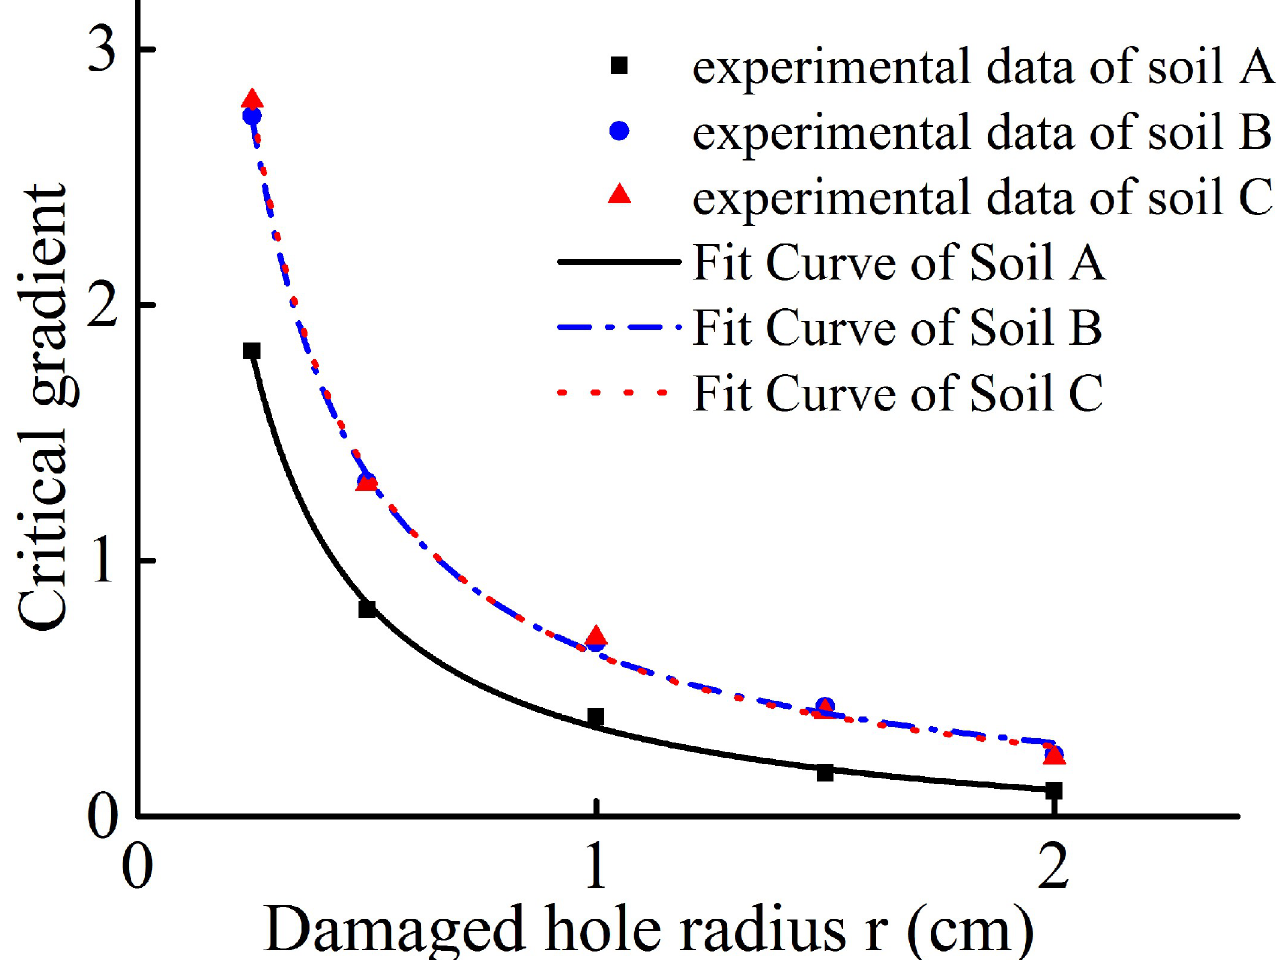
Fig 16. Fitting curves for variation in critical gradient with hole